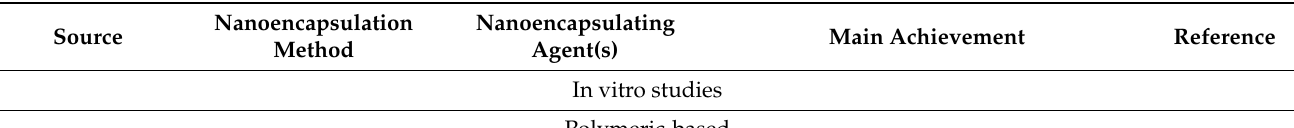
Table 2. In vitro and in vivo studies on the potential therapeutic effects of drug delivery systems nanocarried with